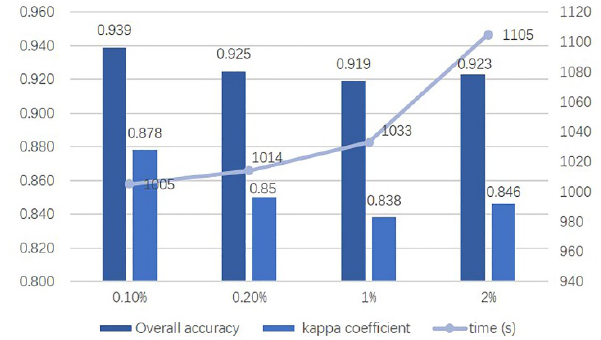
Figure 9. Sampling proportion accuracy